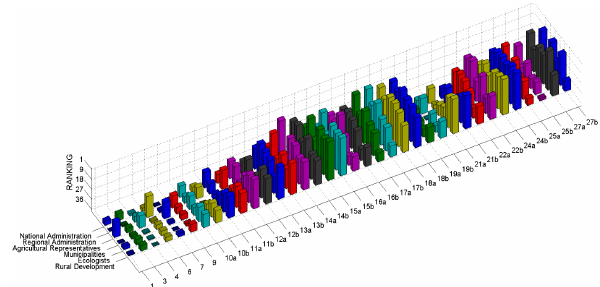
Figure 5. Ranking of alternatives by the stakeholders in scenario 1.